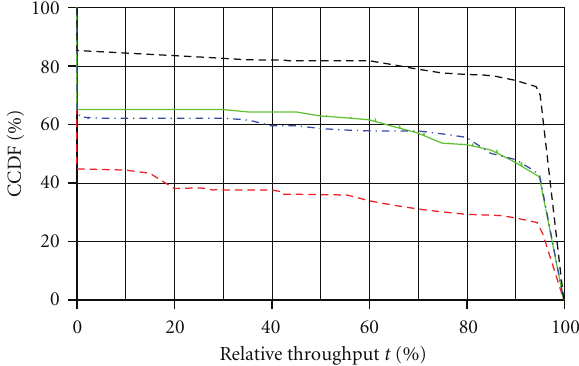
Figure 9: Measured CCDF of throughput for 4 di ff erent LTE devices with di ff erent form-factors and operating frequencies at RS EPRE = − 102 dBm/15kHz using only constellations in the azimuthal plane.